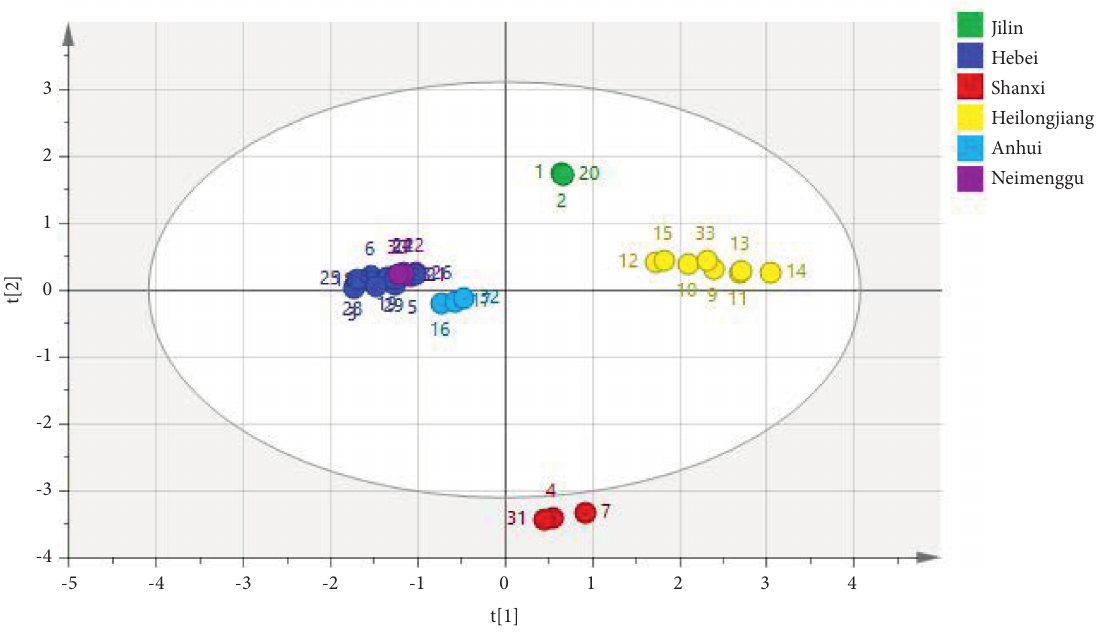
Figure 4: PCA scores of 33 samples of S. divaricata .